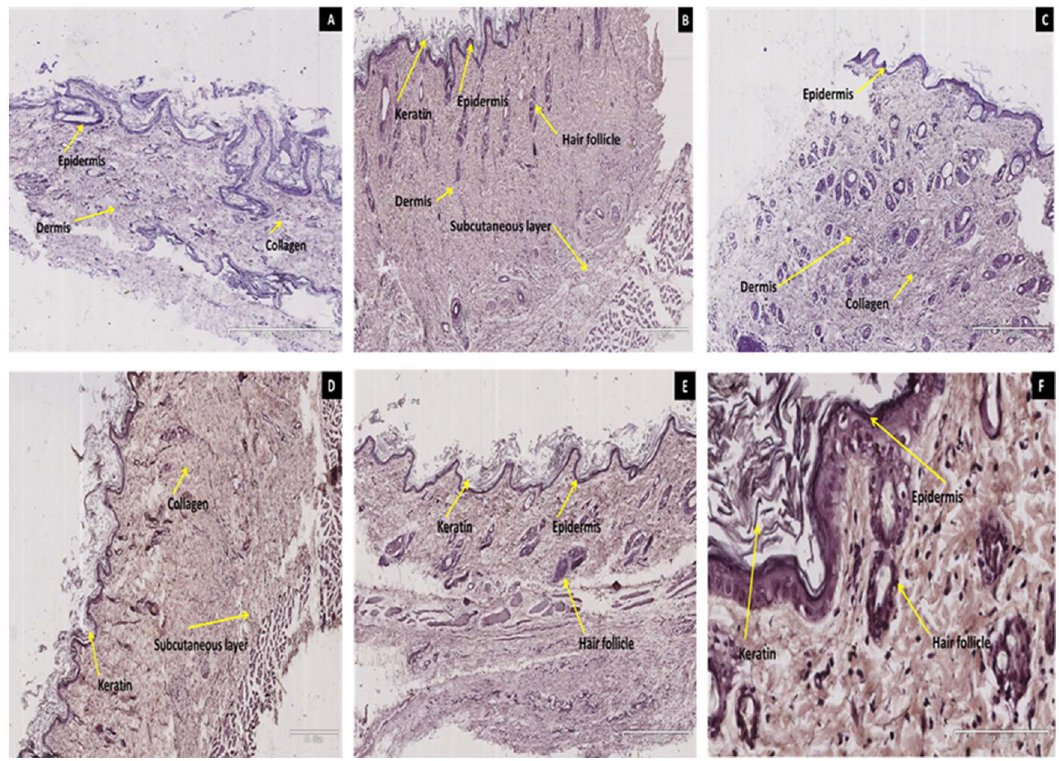
Figure 2. Immunohistochemical micrographs illustrating the effects of transdermally delivered insulin on the expression of Insulin receptor (IR) in skin sections of STZ-induced diabetic rats. The presence of IRS is depicted as brown staining and a method control (A) reveals no immune-reactivity and intense haematoxylin staining (blue) across epidermis and dermis. Untreated non-diabetic rat skin section (B) revealed widespread localization of IRS across the epidermis and dermis. Untreated diabetic control rat skin section (C) exhibited very low immuno-reactivity predominantly in the dermis. Intense immuno-reactivity was observed in the epidemis, dermis and subcutaneous layer of transdermal insulin treated rat skin section (D). Subcutaneous insulin treated rat skin section (E) also exhibited widespread localization of IRS in the epidermis and dermal structures (Mag. 4 6 500 6 m m). All the dermal structures including, collagen and hair follicles were positive for IRS with more intensity in the transdermal treatment (F; Mag 27 6 100 m m).